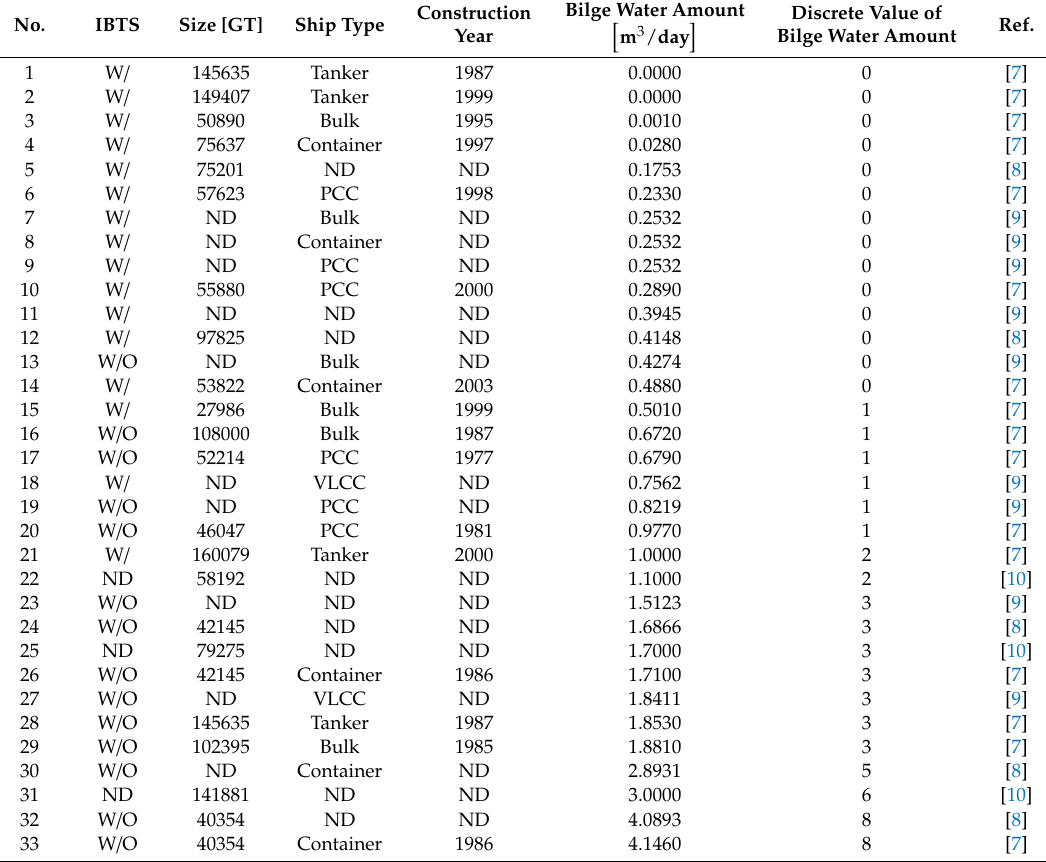
Table 1. Data collected for building statistical models. “ND” (no data) means that the item was unavailable. In the Integrated Bilge Water Treatment System (IBTS) column, “W / ” and “W / O” refer to vessels with and without IBTS, respectively. In the ship type column, PCC and VLCC stand for pure car carrier and very large car carrier, respectively.